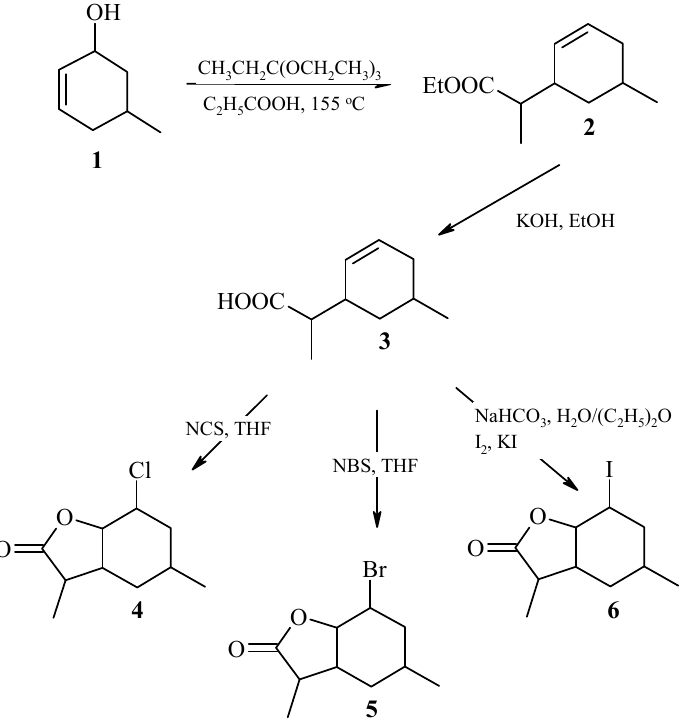
atom in both A and B isomers of lactones 4 – 6 . The signals derived from the protons H-6A and H-6B were broad multiplets. They were in the ranges of 2.32–2.37, 2.39–2.44, and 2.46–2.53 ppm for the A isomer (compounds 4 , 5 , and 6 , respectively). For isomer B, these signals were at 2.67 (dddd, J = 12.4, 10.0, 6.0 and 4.0 Hz), 2.70–2.76, and 2.81–2.89 ppm (compounds 4 , 5 , and 6 , respectively). This means that in both isomers A and B, the C-C bond of the lactone ring assumed the equatorial orientation.